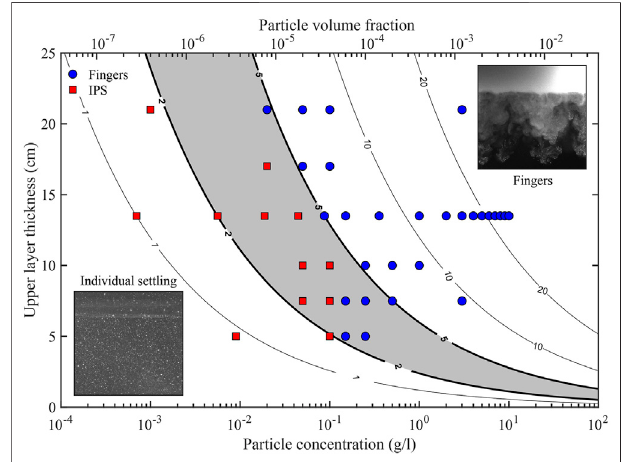
FIGURE 12 | – Contours of L p (cid:2) H c / δ ( Eq. 16 ) calculated for experiments as a function of the upper layer thickness and initial particle concentration. Calculation of L p is performed with Gr (cid:2) Gr exp (cid:2) 10 4 . Blue circles and red squares correspond to experiments associated with fi ngers or individual particle settling (IPS),respectively( Table 2 ).Thegray area 2 < L p < 5 indicates the transition between experiments with fi ngers and individual particle